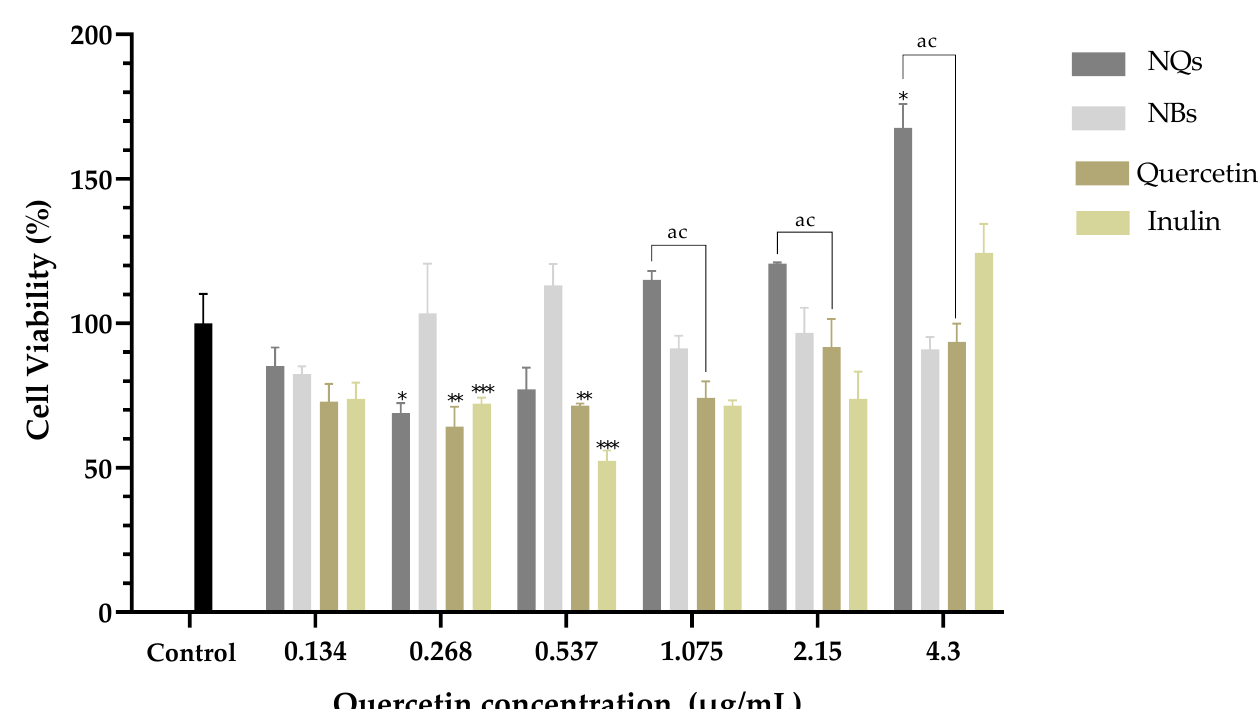
Figure 13. Cell viability in human dermal fibroblast cell line (HDFa). Cell viability (%) of inulin nanoparticles loaded with quercetin (NQs), inulin non-charged nanoparticles (NBs), quercetin and inulin at different concentrations (4.3 to 0.134 μg/mL) in human dermal fibroblast cell line (HDFa) after 24 h, determined using the MTS assay. Values are expressed as mean ± SD. Controls are untreated cells. Significant differences among treatments in the cell lines were determined based on Dunnett multiple comparison test ( p ≤ 0.05) where * represents control vs. NQs, ** represents control vs. quercetin and *** represents control vs. inulin. Significant differences were determined based on the Student’s t -distribution ( p ≤ 0.05) where ac represents NQs vs. quercetin.